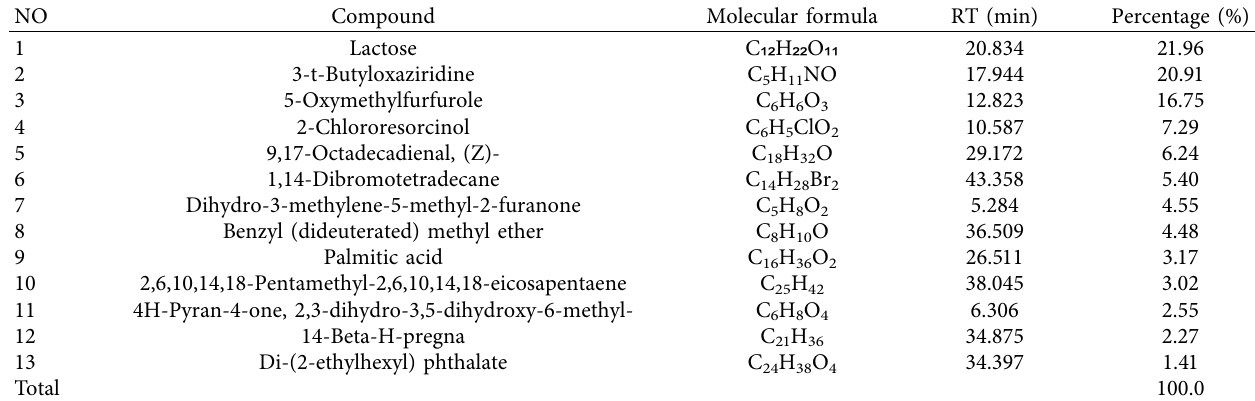
Table 4: GC-MS analysis of the hydroalcoholic extract of